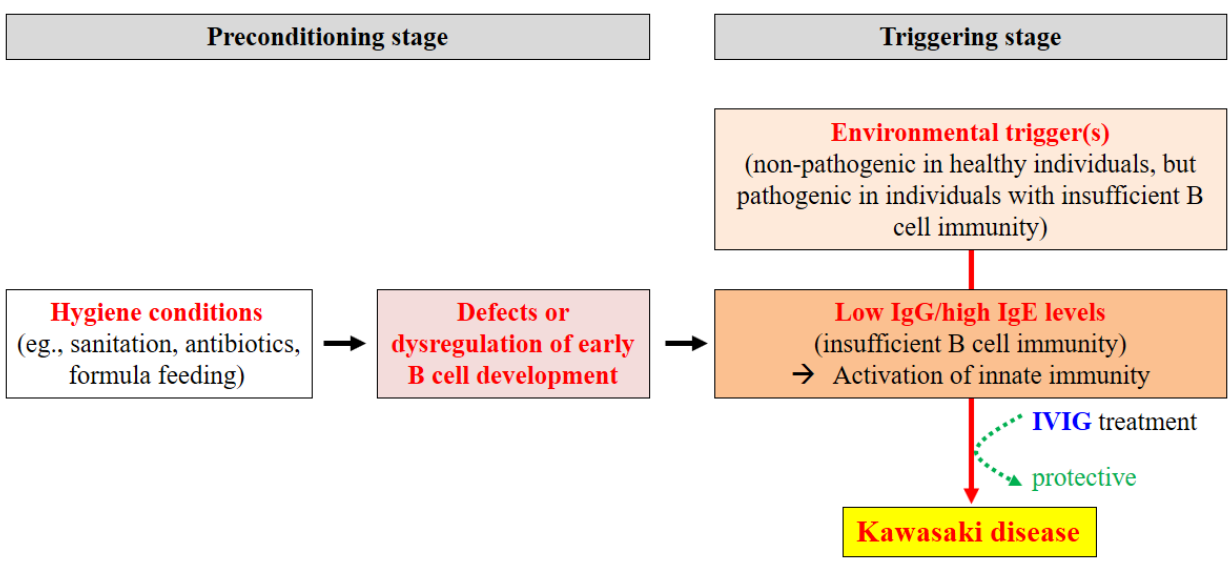
Figure 5. Proposed mechanism underlying the hygiene-hypothesis-driven etiopathogenesis of KD. IVIG, intravenous im- munoglobulin.